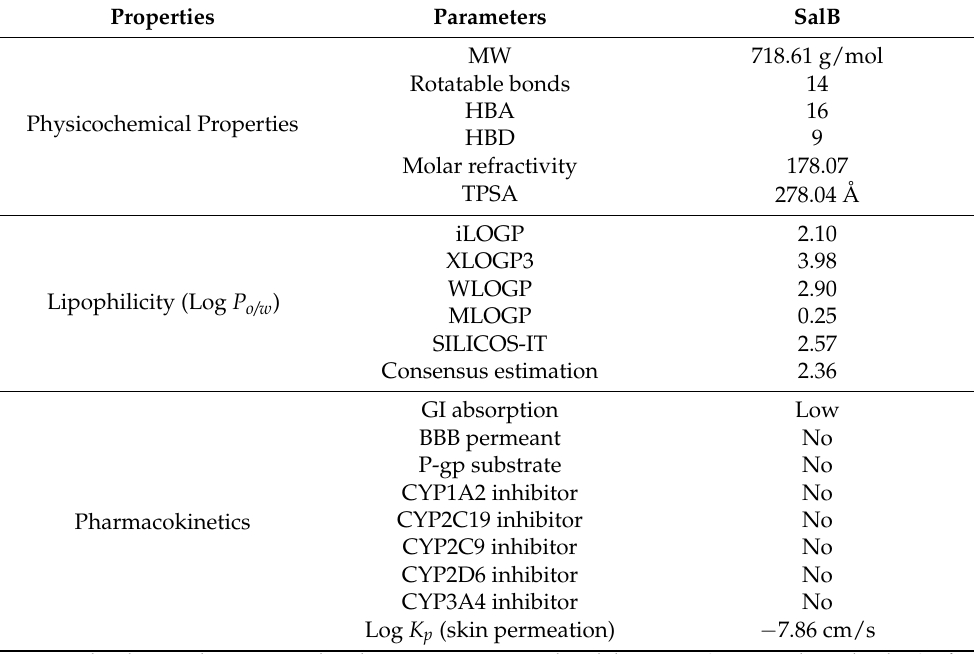
Table 1. SwissADME (absorption, distribution, metabolism and excretion) parameters attributed to